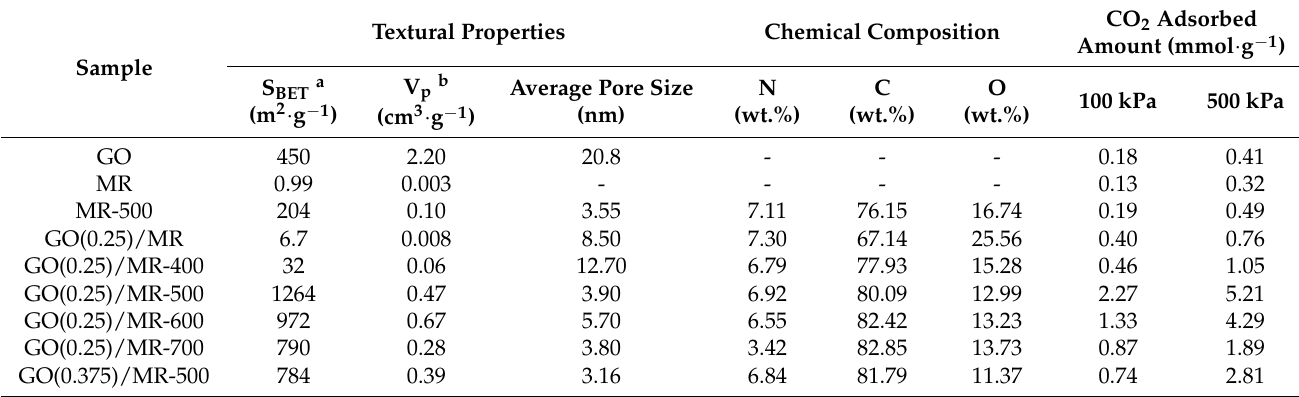
Table 1. Porous structure, chemical composition and CO 2 uptake of GO, MR, GO/MR and GO/MR-derived porous carbon materials obtained at different temperatures.